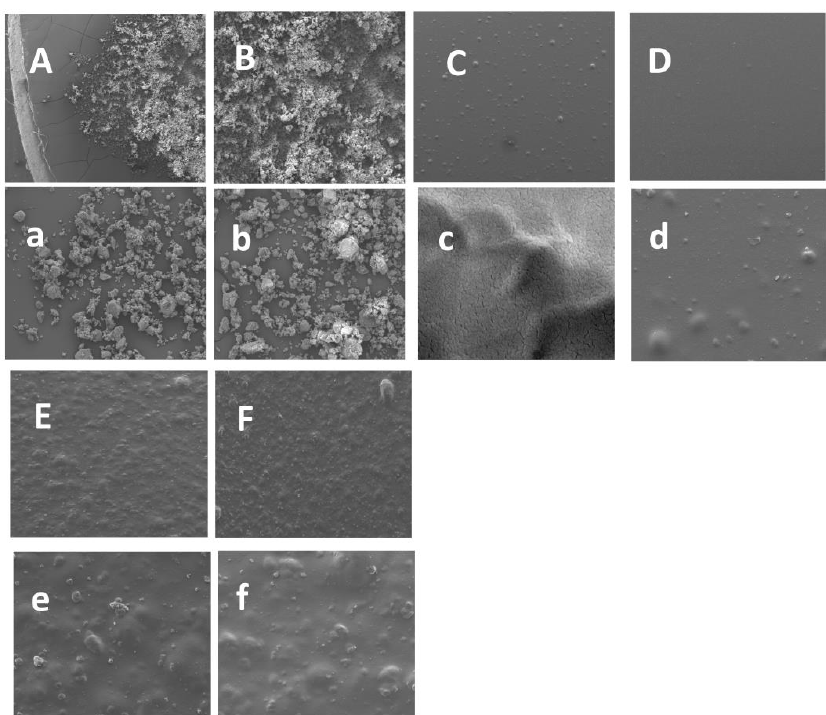
Figure 4. SEM topography of TiO 2 ( A , a ), doped-TiO 2 powders ( B , b ), neat zein films ( C , c ), single-layered zein films incorporated with doped-TiO 2 powders at 2% ( D , d ) and 10% ( E , e ), and double-layered film containing doped-TiO 2 powders of 2%. Field width: 5.5 mm ( A – F ) and 275 μm ( a – f ).